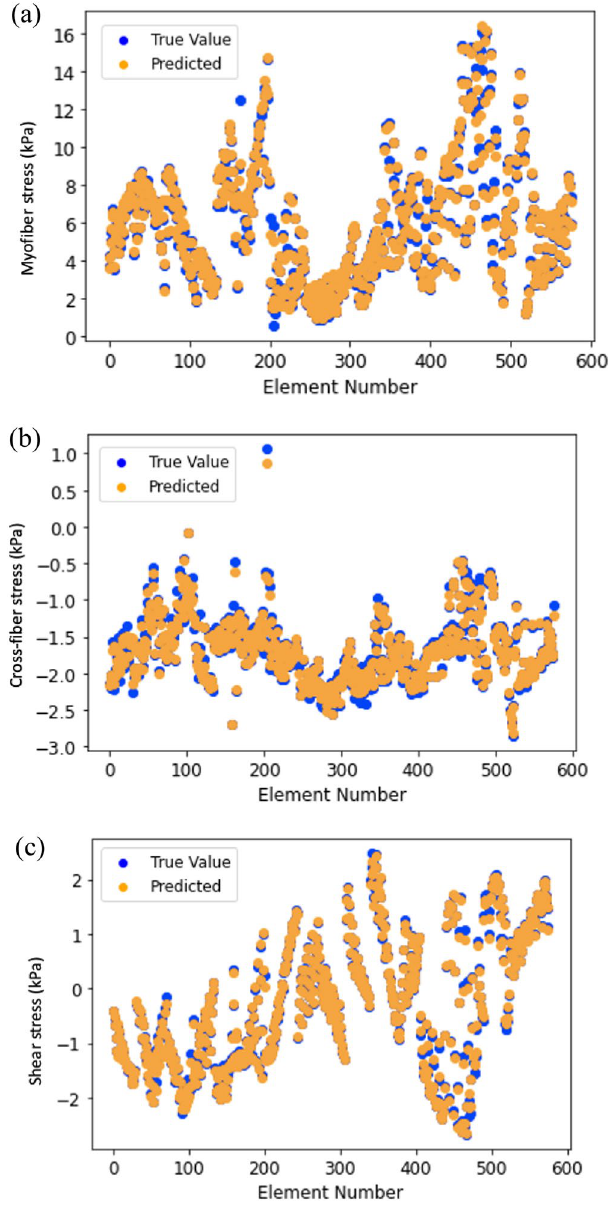
Figure 4. ( a ) Myofiber stress from FE (blue) and feed forward DL (orange); ( b ) Cross-fiber stress from FE (blue) and feed forward DL (orange); ( c ) Shear stress from FE (blue) and feed forward DL (orange).